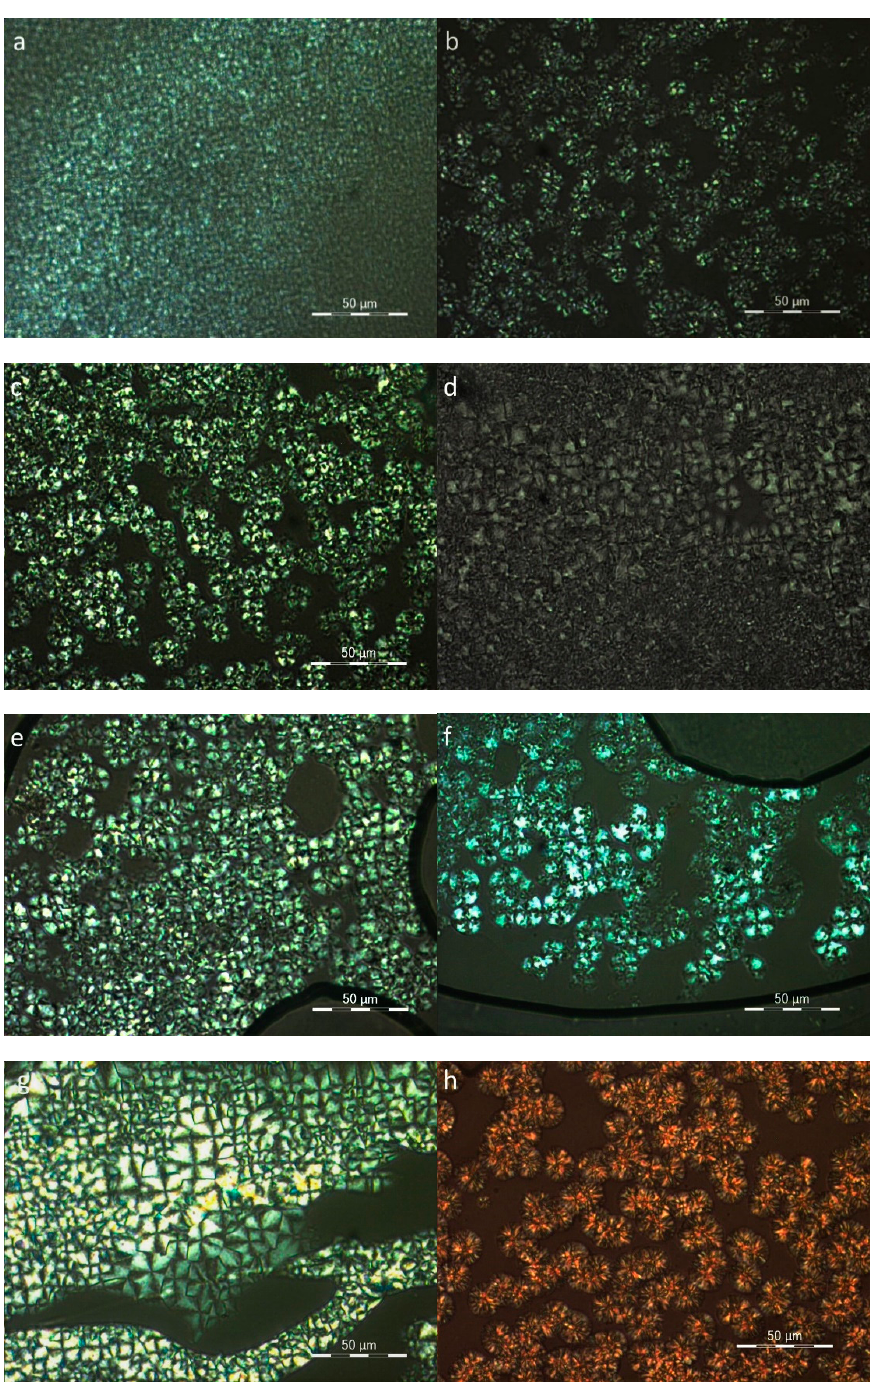
Figure 11. PLM photos recorded at 210 °C for the blends: ( a ) neat PET, ( b ) PET-PEF 90-10, ( c ) PET- PEF 80-20, ( d ) PET-PEF 60-40, ( e ) PET-PEF 50-50, ( f ) PET-PEF 40-60, ( g ) PET-PEF 30-70, ( h ) neat PEF.